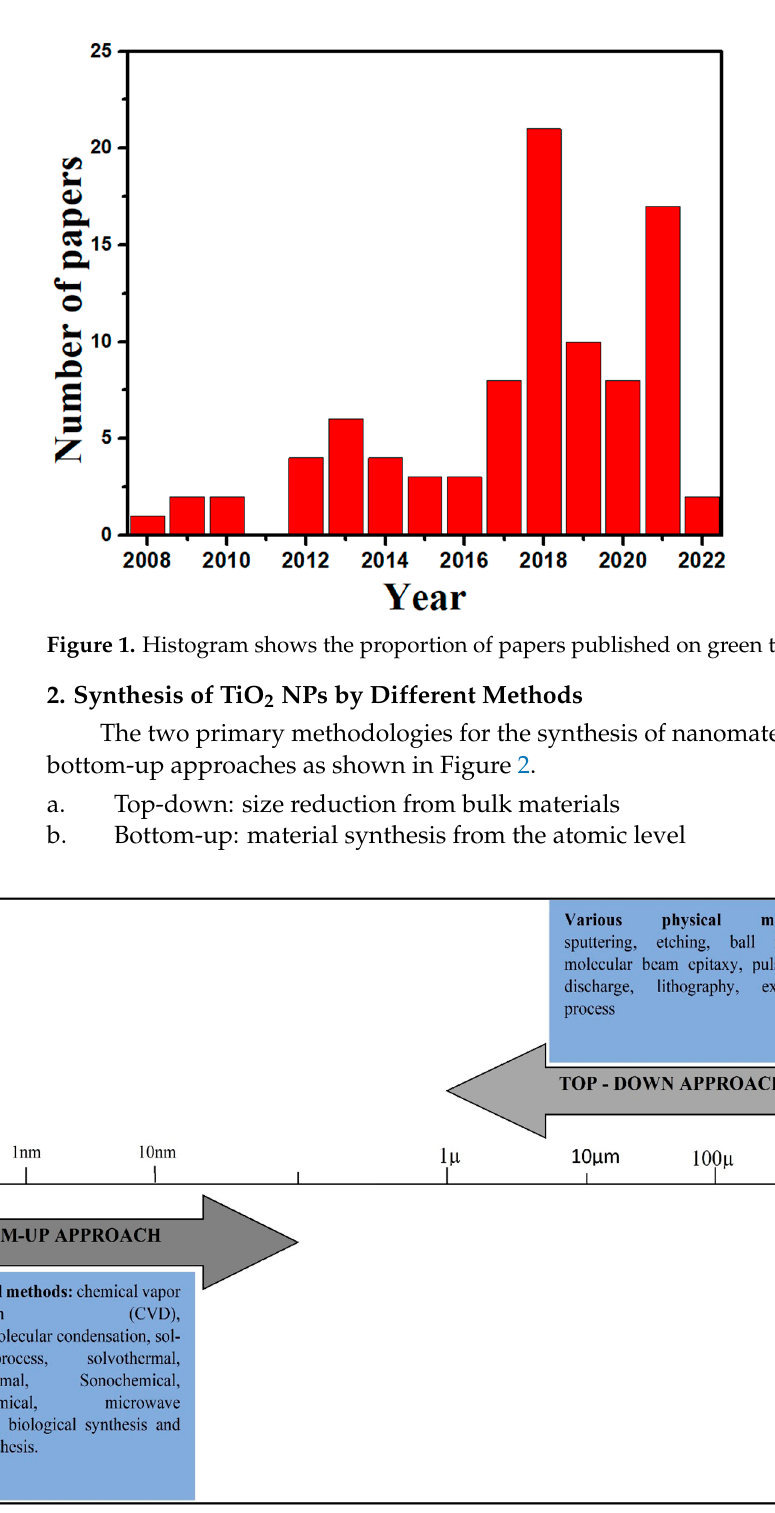
Figure 2. Nanoparticle synthesis methods.